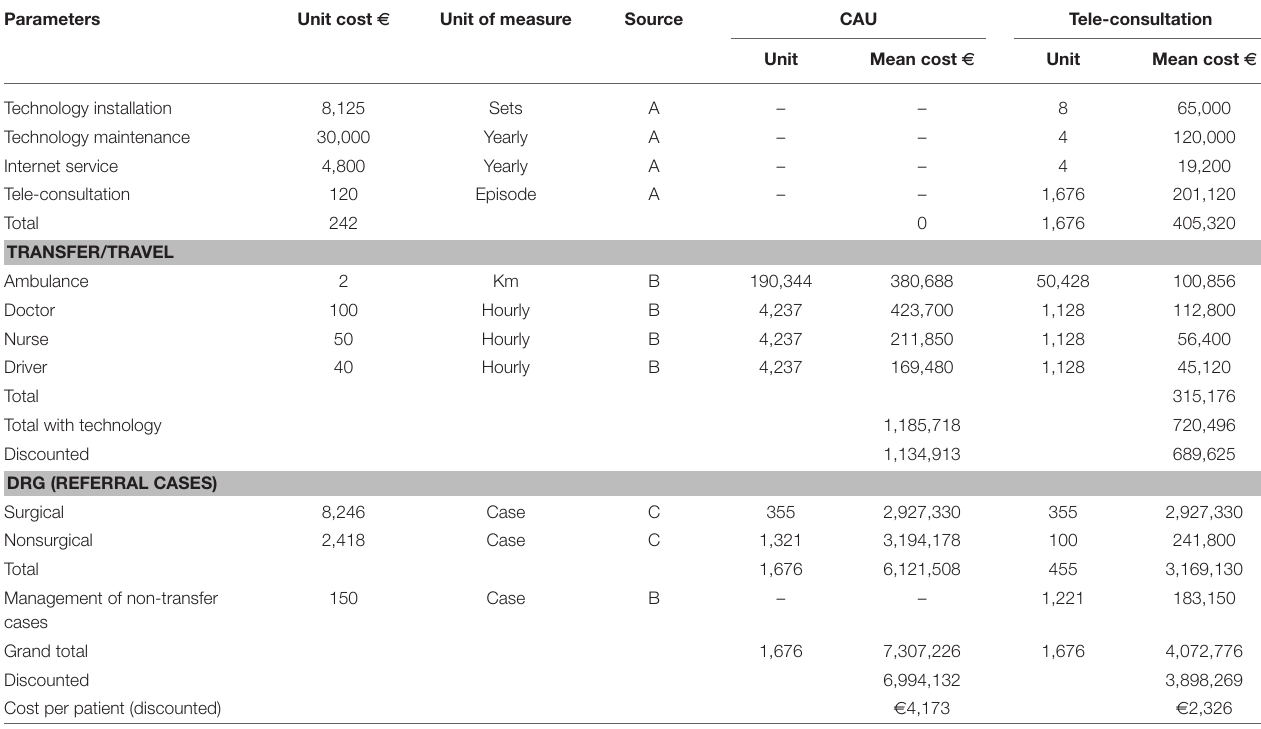
TABLE 1 | Use of health care resources and costs for emergency neuro-surgical case management in Tele-medicine intervention.